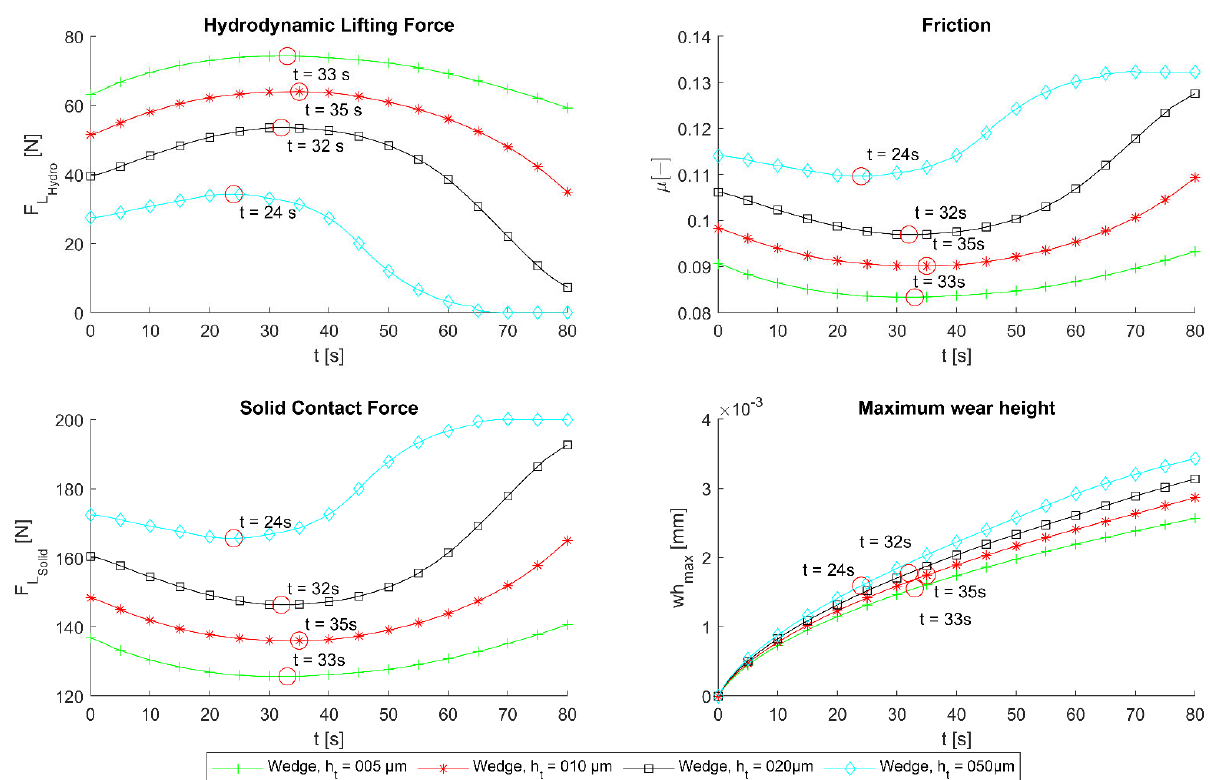
Figure 10. Reversal points in the wear dependent characteristic curves .